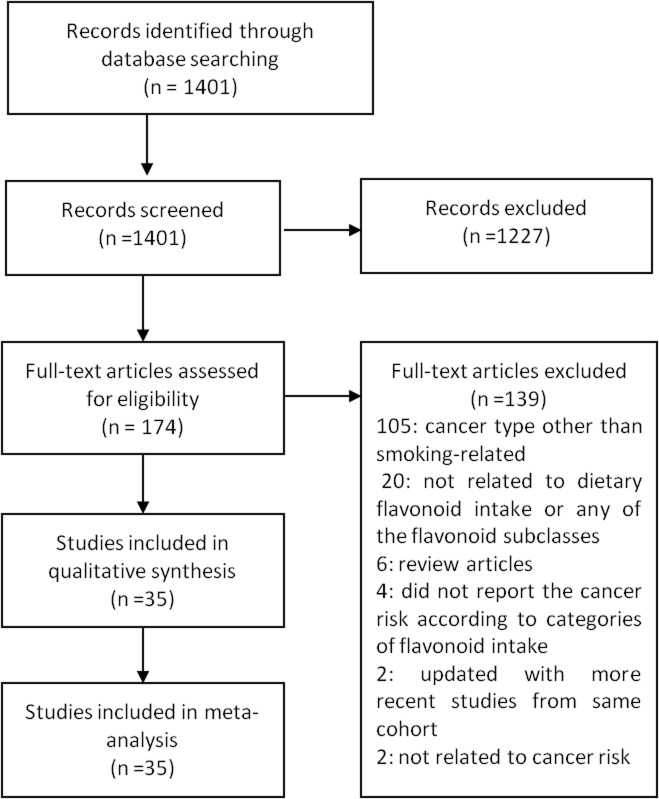
Flow diagram of study selection.